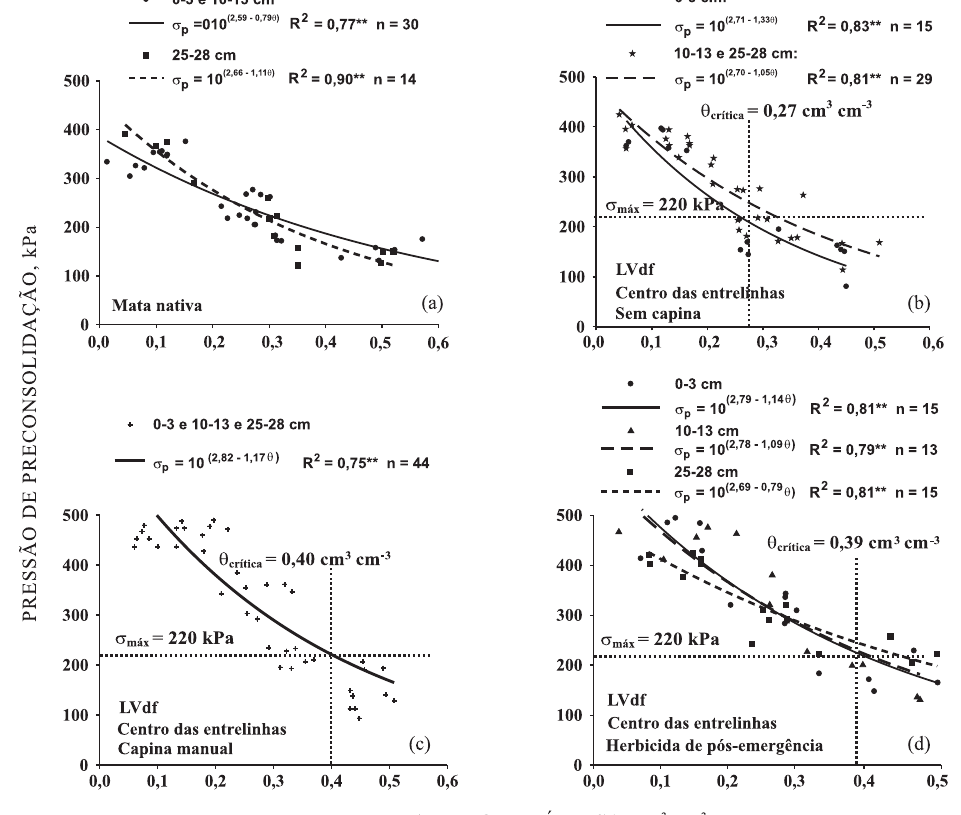
Figura 2. Modelos de capacidade de suporte de carga para um Latossolo Vermelho distroférrico (LVdf) sob mata nativa (a) e cultivado com cafeeiros sob os manejos de plantas invasoras sem capina (b), capina manual (c) e herbicida de pós-emergência (c) na posição de amostragem centro das entrelinhas dos cafeeiros em três profundidades. A linha pontilhada horizontal representa a tensão máxima de 220 kPa ( σσσσσ ) aplicada pelo trator utilizado no manejo. As linhas pontilhadas verticais representam as umidades máx críticas ( θθθθθ ) para o tráfego do crítica